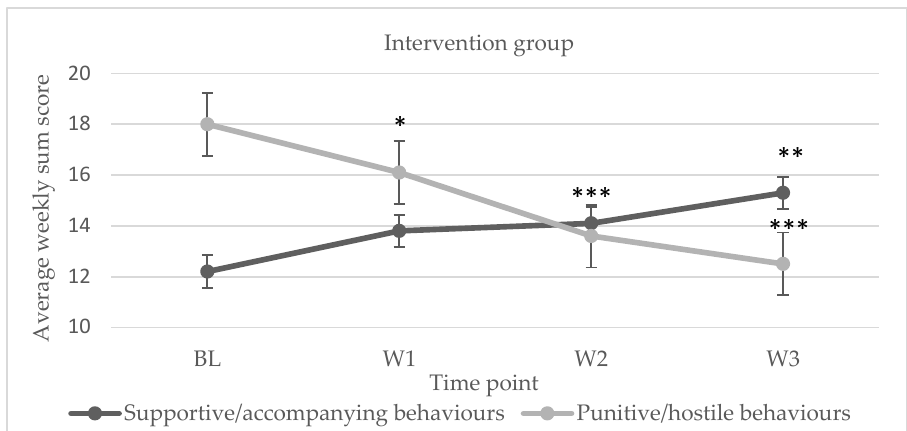
Figure 2. Evolution of family interactions for the intervention group. Note. Supportive/accompanying and punitive/hostile interactions over the three weeks the intervention was implemented. Error bars show the standard error of the mean (SEM). * p < 0.05, ** p < 0.01, *** p < 0.001. All the points shown in the graph are statistically significant regarding BL.